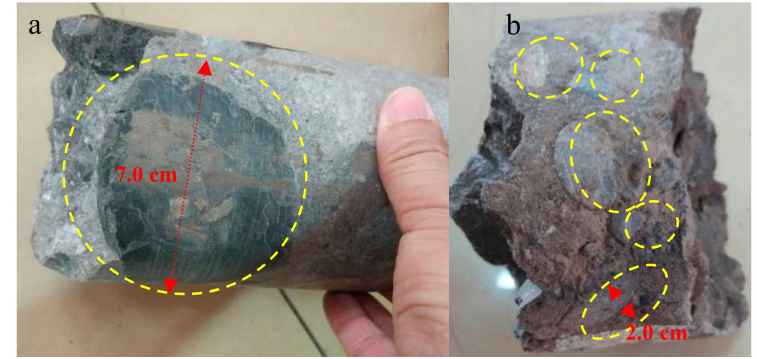
Figure 2. ( a , b ) drill cores from Figure 1b showing closer morphology of tight glutenite. The conglomerate gravels are shown inside the yellow circles